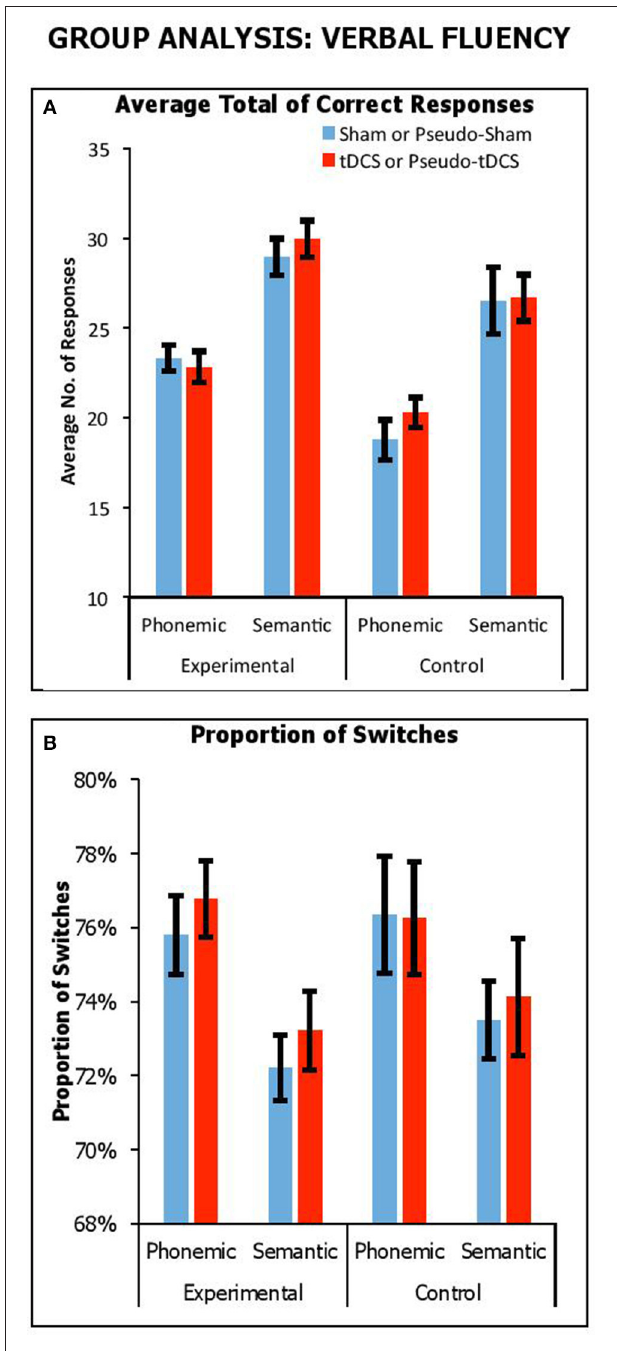
FIGURE 1 | Performance across stimulation conditions (sham vs. tDCS conditions for experimental group; pseudo-sham vs. pseudo-tDCS for control group) and fluency tasks in terms of overall average no. of correct responses (A) and proportion of switches (i.e., average no. of switches over average response) expressed as a percentage (B) . Error Bars indicate Standard